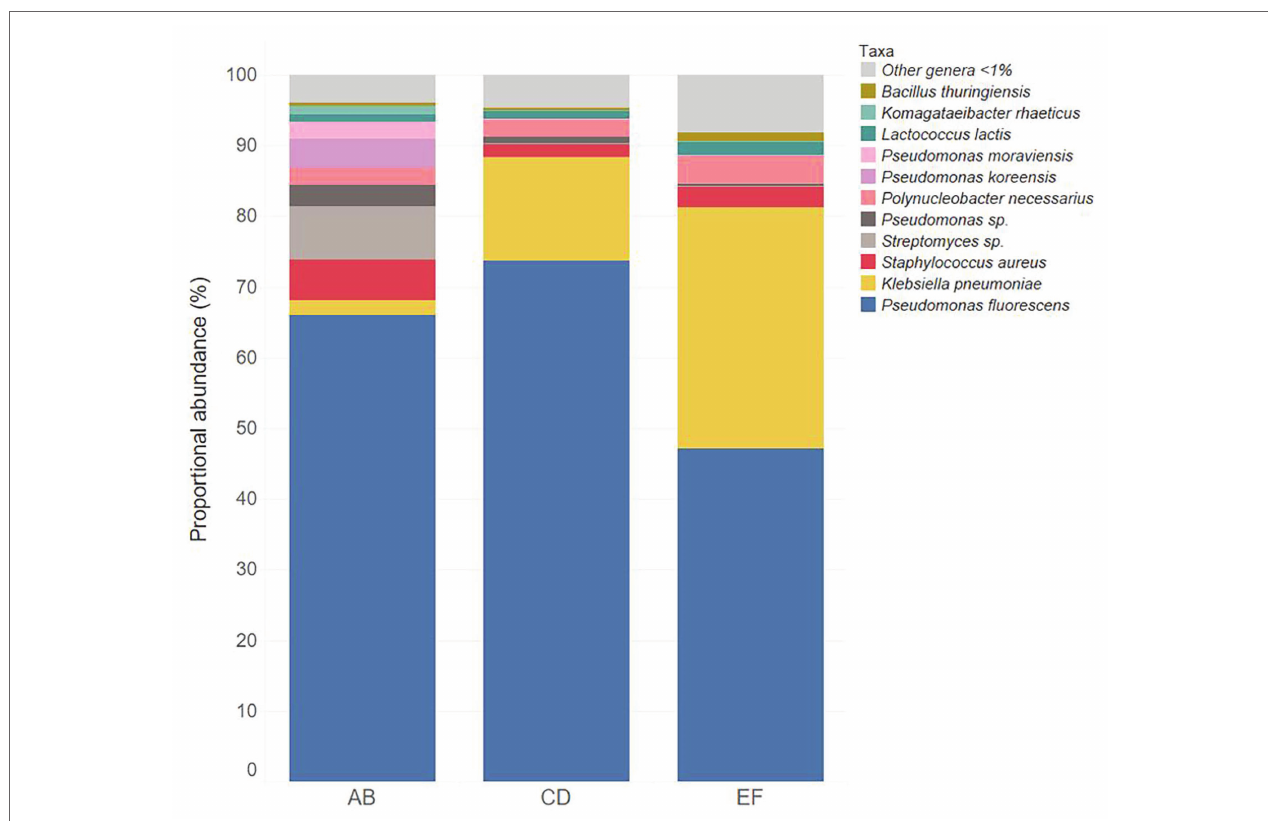
FIGURE 1 | Relative abundance of bacterial taxa in the three batches of unpasteurized milk (AB, CD, and EF) used in this study used to make Gouda